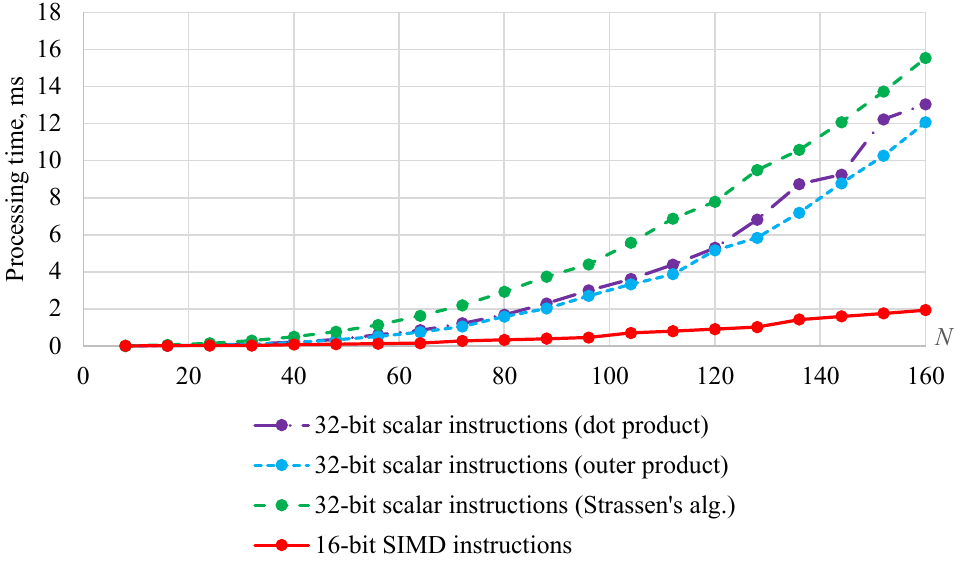
13 of 17 Figure 8. Splitting of the rightmost matrix on vertical blocks and the leftmost matrix on strips for parallel processing. 8. Results and Discussion In this section, we compare processing times of several matrix multiplication algo- rithms implemented on the sole IP core. The used pipeline-accurate software simulator allows us to estimate processing time precisely. We are interested in multiplication of ma- trices having sizes of about one hundred. Figure 9 and Table 1 show an advantage of matrix multiplication by means of 16-bit vector instructions in comparison with solutions that used 32-bit scalar instructions. We implement three algorithms for handling 32-bit scalars: based on dot product; based on outer product, and Strassen’s algorithm. Overhead of Strassen’s algorithm for the consid- ered range of matrix sizes is significant, because the total number of operations is higher in comparison with matrix multiplication via inner or outer product. Processing times of implementations via dot product and inner product for scalar instructions are close. The realization via outer product slightly better uses the VLIW pipeline. Processing time of the proposed algorithm via SIMD 16-bit instructions for matrix 160 by 160 of 16.16 fixed